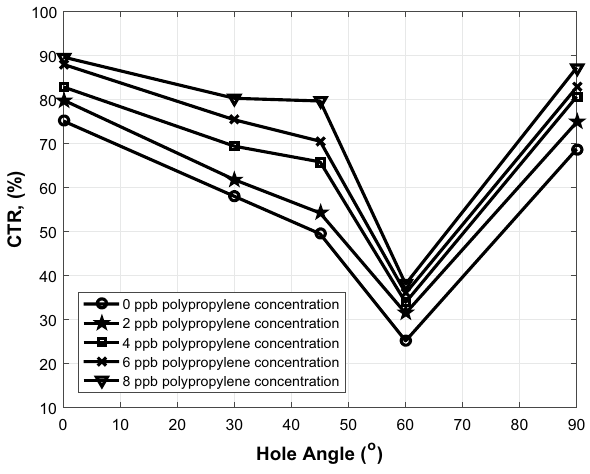
Fig. 3 Cutting transport ratio vs. hole angle for cuttings size of 0.5– 1.0 mm and pipe rotation of 0